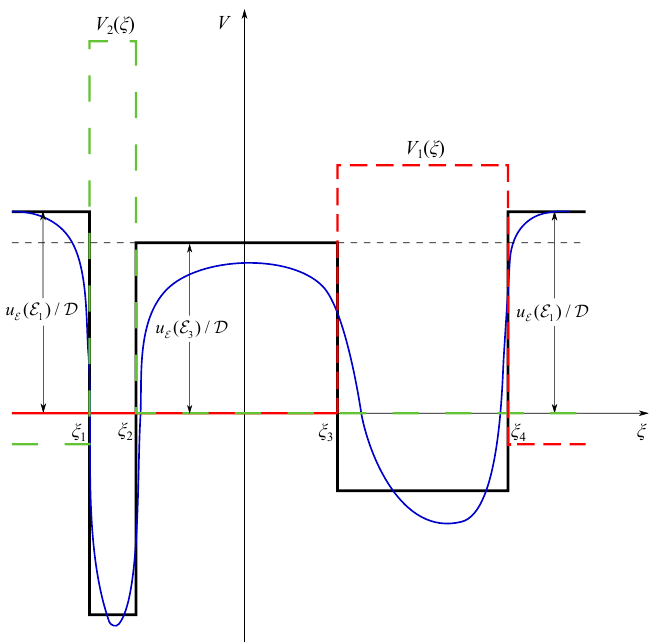
Figure 4. Schematically: The actual double-well potential V ( ξ ) (smooth blue line). The approximation of V ( ξ ) by the double-well square potential, V DWS ( ξ ) , is shown in black; ξ 1,2,3,4 designate the coordinates of the walls of the wells. U 1,2 ( ξ ) = V DWS ( ξ ) + V 1,2 ( ξ ) are the potentials of the single- well approximation, when tunneling is